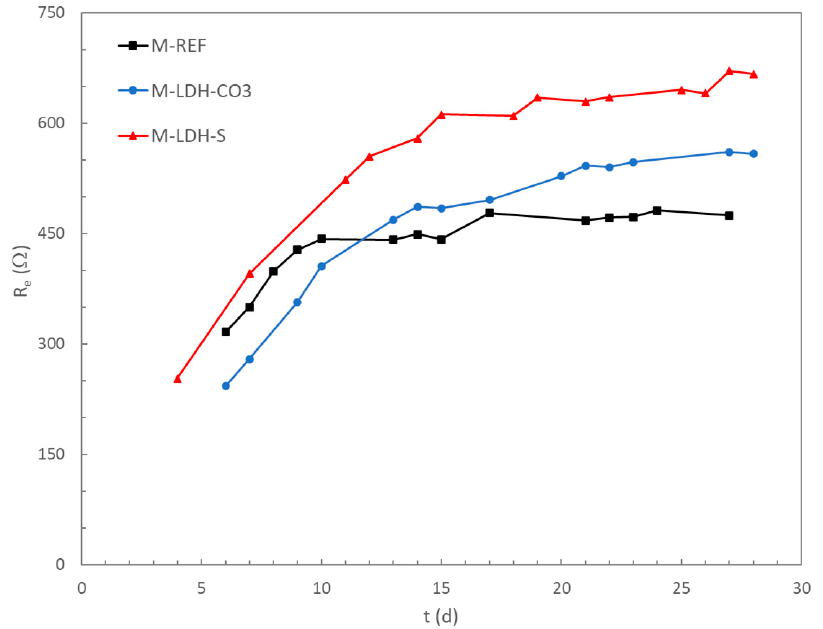
Figure 7. Evolution of the electrical resistance for the three studied reinforced mortars during the passivation period.